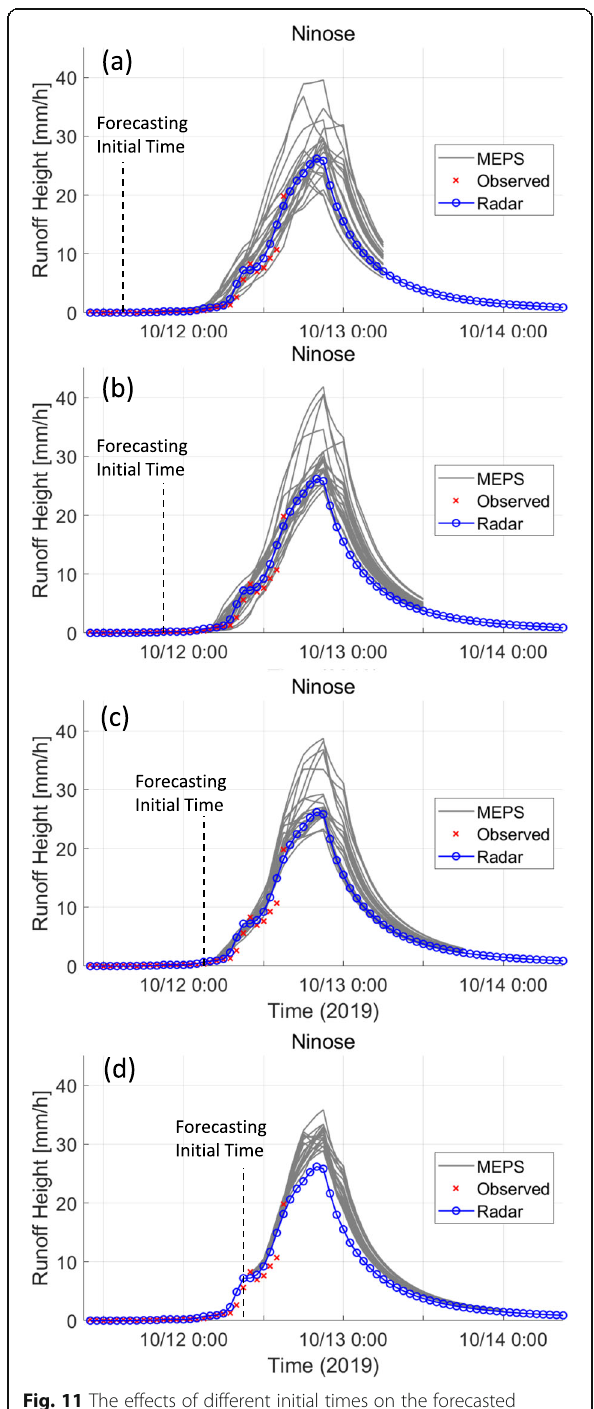
Fig. 11 The effects of different initial times on the forecasted hydrographs at Ninose dam. The “ MEPS ” shows the forecasted results initialized at a 15:00 11 October, b 21:00 11 October, c 3:00 12 October, and d 9:00 12 October